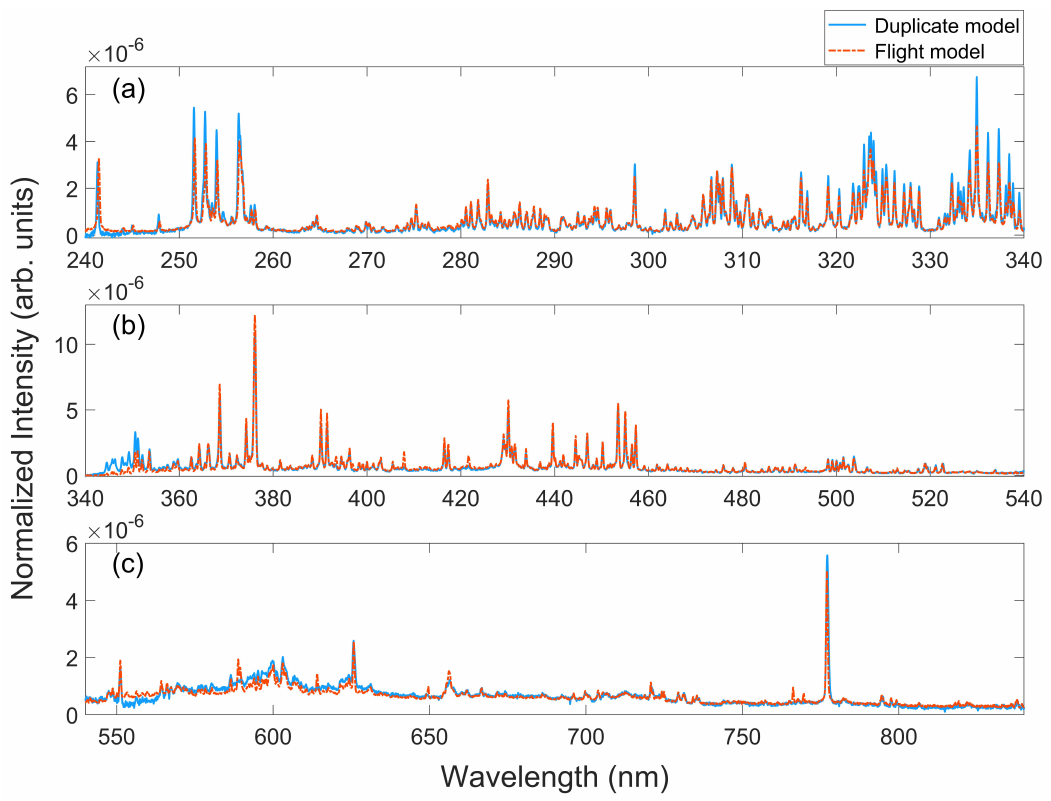
Figure 11. The LIBS spectra of a Ti alloy sample collected by the MarSCoDe flight model (red dashed lines) and the duplicate laboratory model (blue lines) in a simulated Martian environment. The detection distance is 3 m. ( a ) The spectra in Channel 1. ( b ) The spectra in Channel 2. ( c ) The spectra in Channel